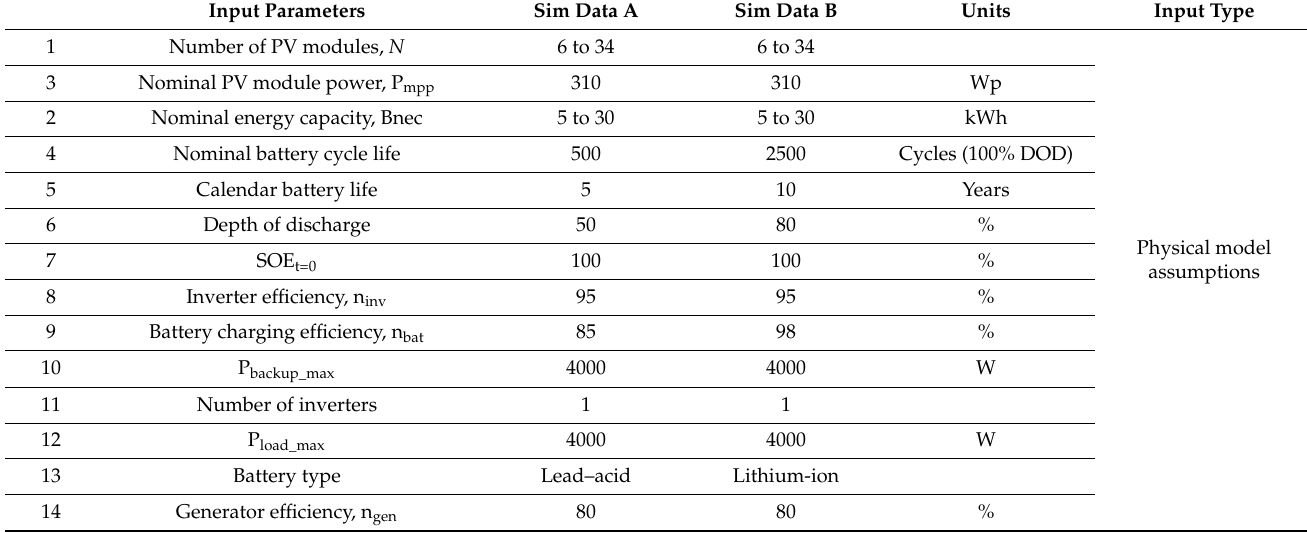
Table 1. Input data of two off-grid PV–battery–generator sizing simulations employing different electrical energy storage (EES) technologies. DOD, depth of discharge; SOE, state of energy; BMS, battery management system; LCOE, levelized cost of electricity; LHV, lower heating